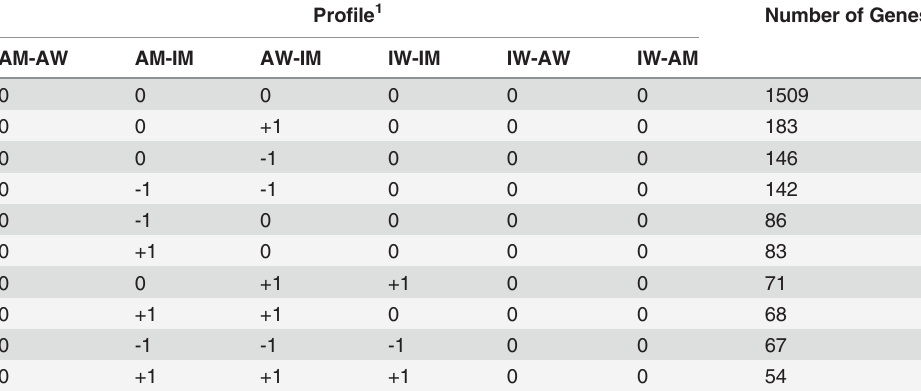
Table 3. Most common pro fi les of over- (denoted with +1), under- (denoted with-1) and not (denoted with 0) differentially expressed (P-value < 0.0001) genes across the 6 pairwise contrasts. Pro fi le 1